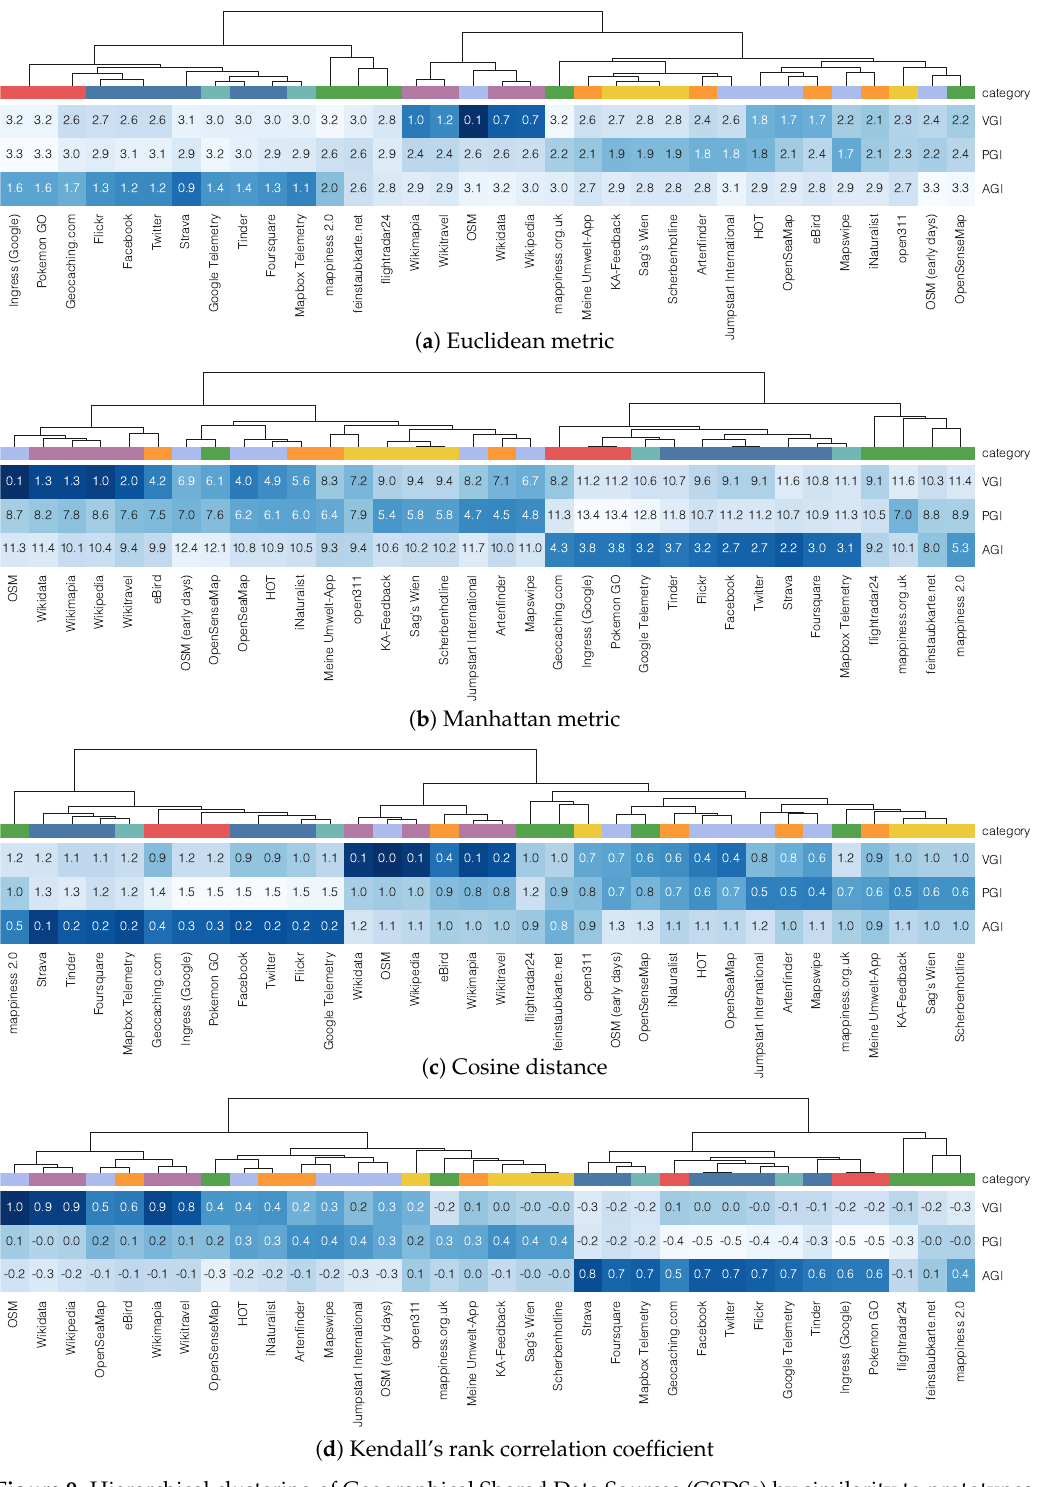
Figure 9. Hierarchical clustering of Geographical Shared Data Sources (GSDSs) by similarity to prototypes, using four different distance measures. For Kendall’s rank correlation coefficient, high values indicate high similarity, for the other three measures, low similarity. The colour scale was set individually for each plot using the respective minimum and maximum value. The legend for the categories can be found in Figure